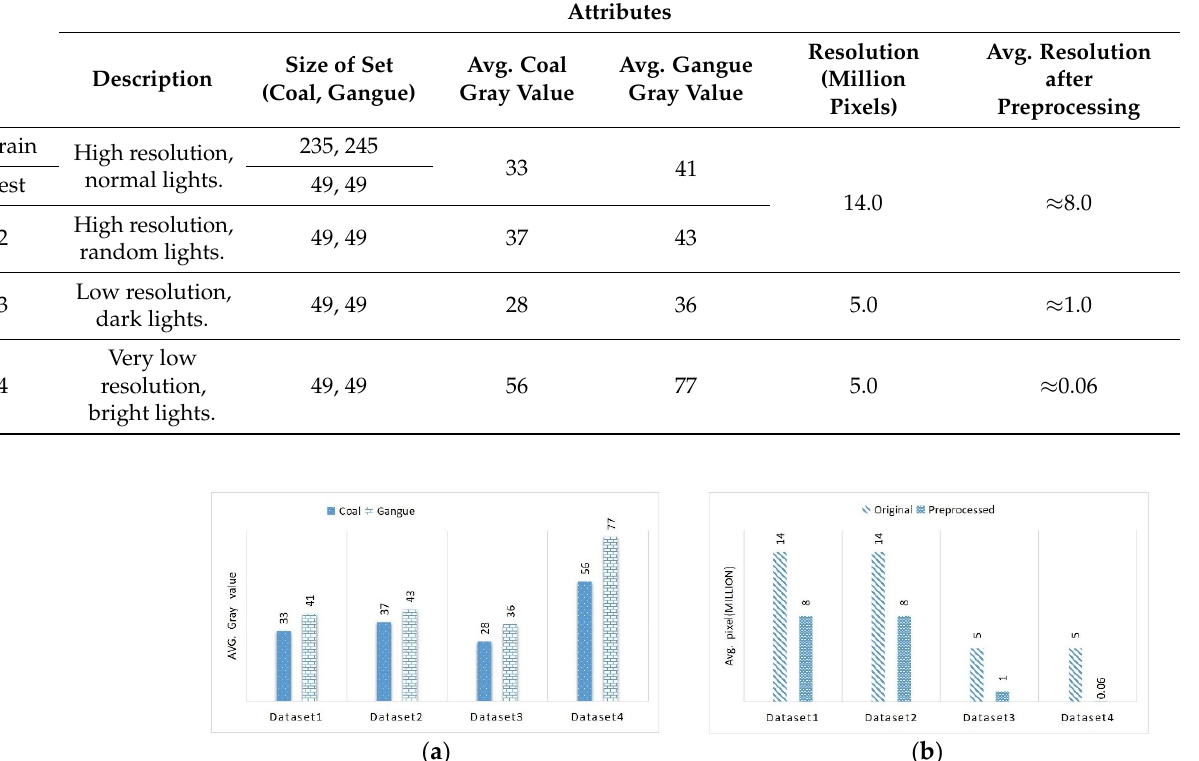
Figure 5. Feature parameters vary among datasets: ( a ) The gray value of images; ( b ) Pixel numbers. Table 1. Metadata of dataset.